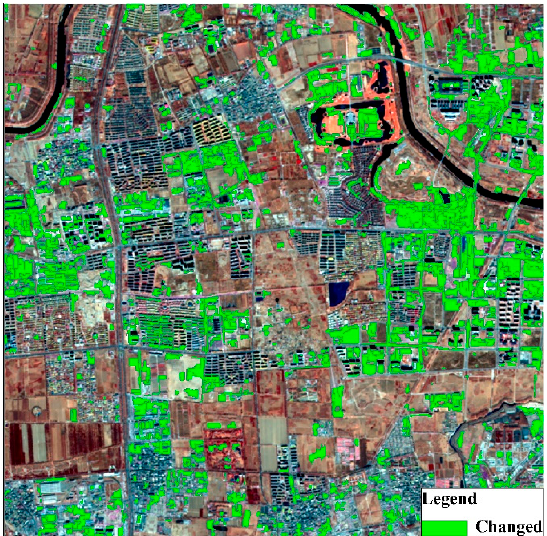
Figure 15. SCCD land cover change detection result overlaid on the GF-1 image of Beijing in February 2017. Table 5. Confusion matrix for the maximum Kappa coefficient of single-constrained change detection